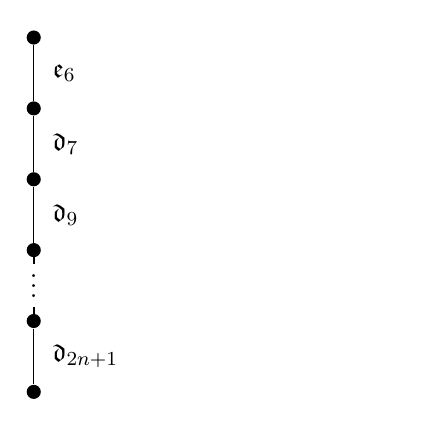
Figure 2 . Hasse diagram for the AD [ D 2 n , D 2 n ] singularity, which has the IR gauge theory descrip- tion SU( n ) + (2 n + 1) F ± 3 / 2